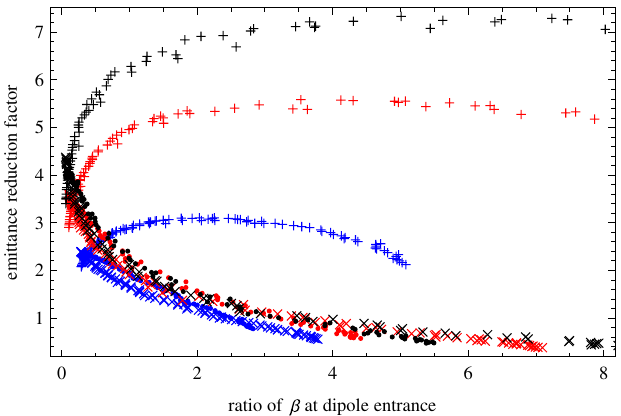
FIG. 13. Relative changes in initial (cid:8) functions at the dipole entrance for the optimal solutions. Lattices are marked by AME ( (cid:2) ), TME ( þ ), and EME ( (cid:7) ). Peak-field strength factors are 2 (blue), 4 (red), and 6 (black).